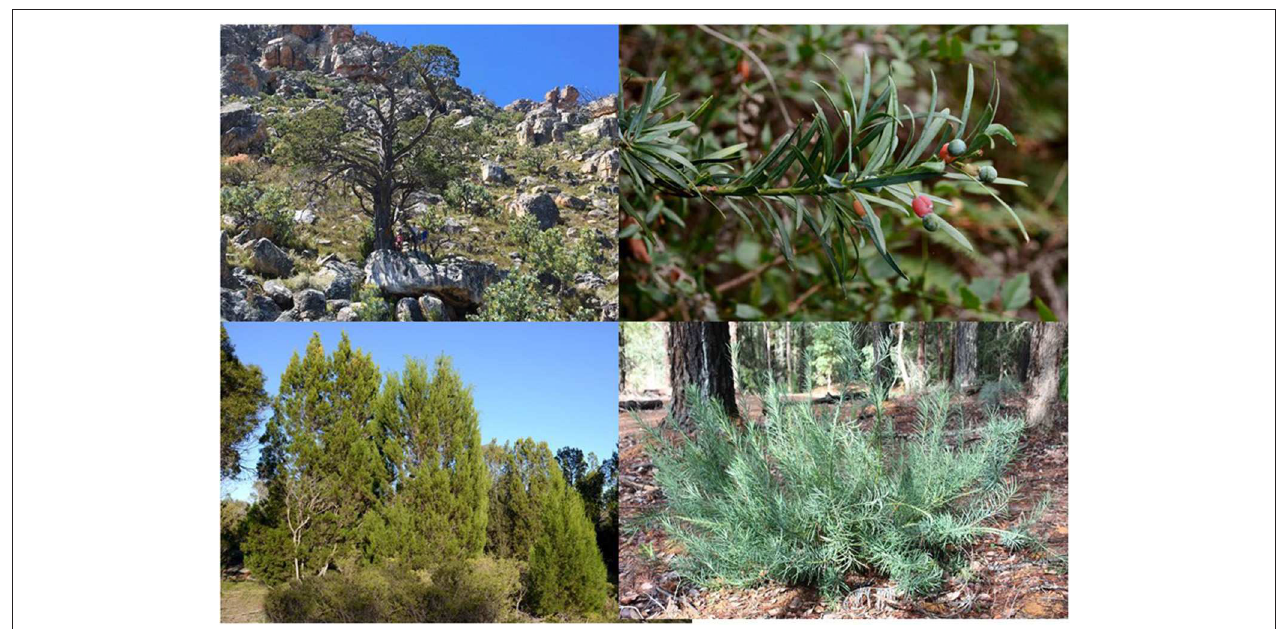
FIGURE 6 | Endemic conifers from the Cape Region of South Africa: Widdringtonia wallichii , Cupressaceae (photo by Linda Marie Botes); Podocarpus elongatus, Podocarpaceae (photo by galanhsnu), and Southwestern Australia: Callitris preissii , Cupressaceae (photo by Botanic Gardens and Parks Authority), Podocarpus drouyanianus , Podocarpaceae (photo by